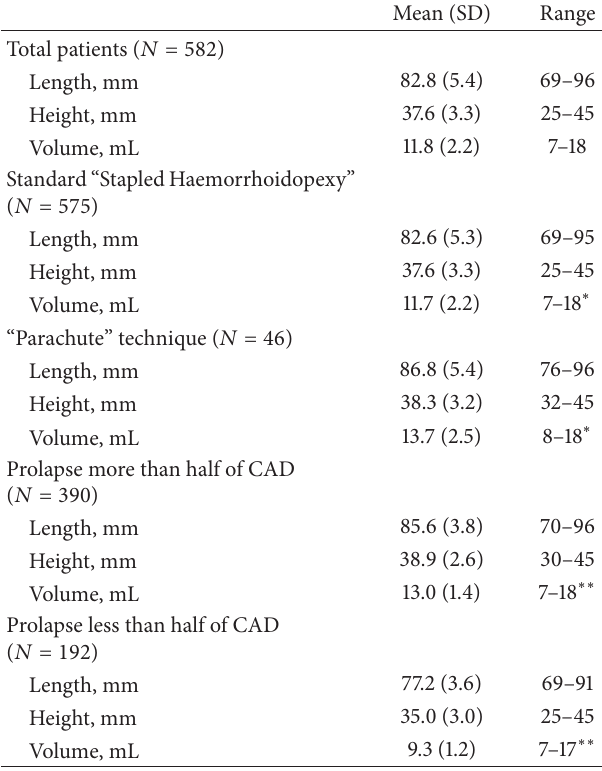
Table 3: Specimen measures available, stratified by type of pro- lapsectomy (standard “Stapled Haemorrhoidopexy” or “Parachute” technique) and extent of rectal